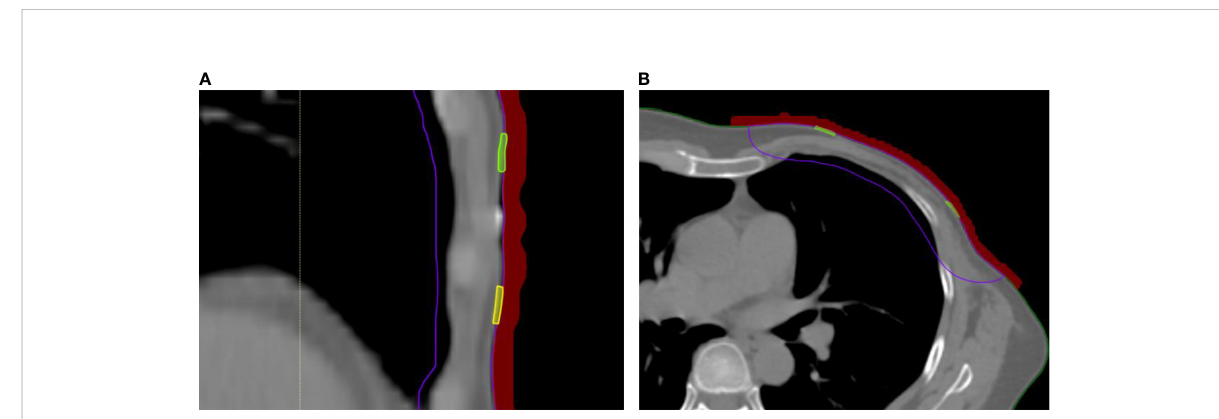
FIGURE 2 In-vivo skin doses measurement in RayStation TPS. (A) Coronal scan with bolus covering small fi lm. (B) Cross-sectional scan with bolus covering small fi